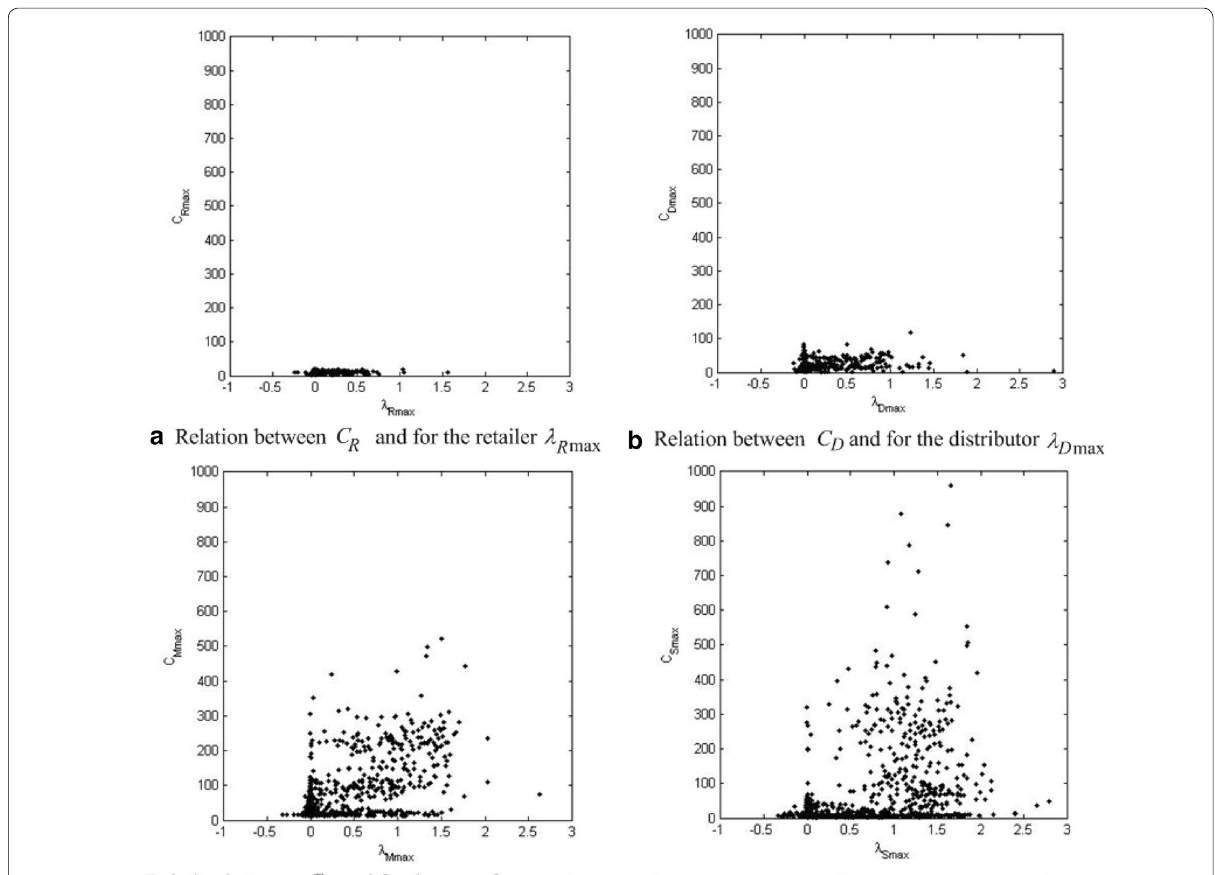
Figure 5 Relation between C i (α I , α SL ) and (cid:31) i max (α I , α SL ) for each